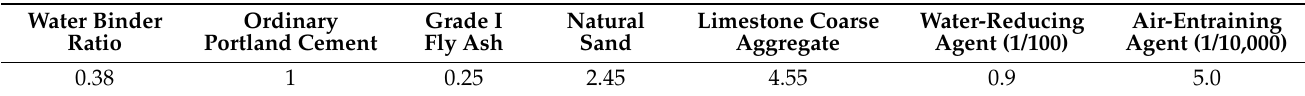
Table 1. Concrete mix proportion.